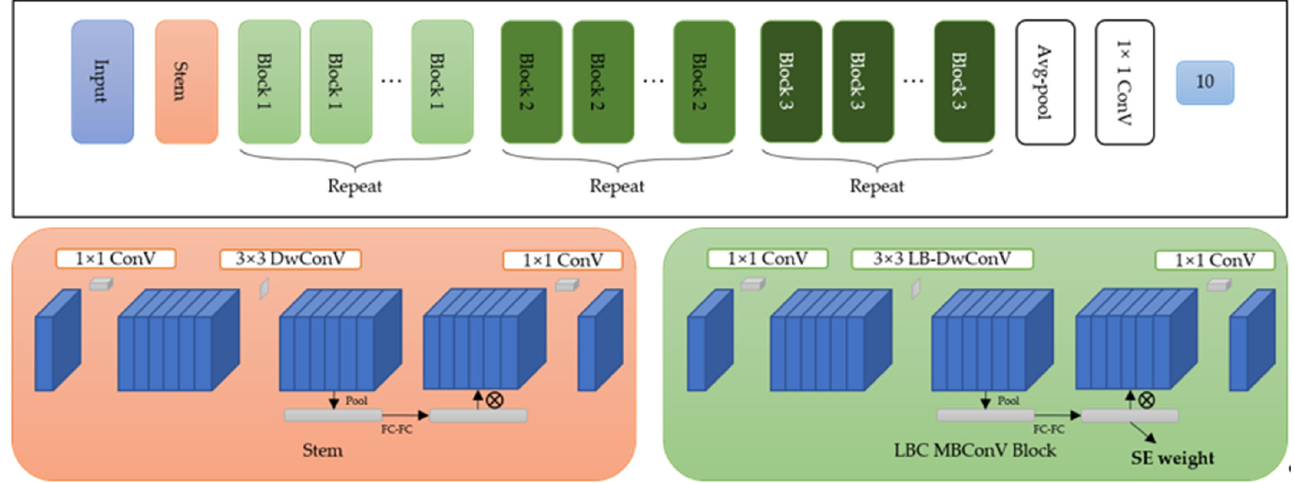
Figure 3. The proposed baseline LB-MBNet model framework.